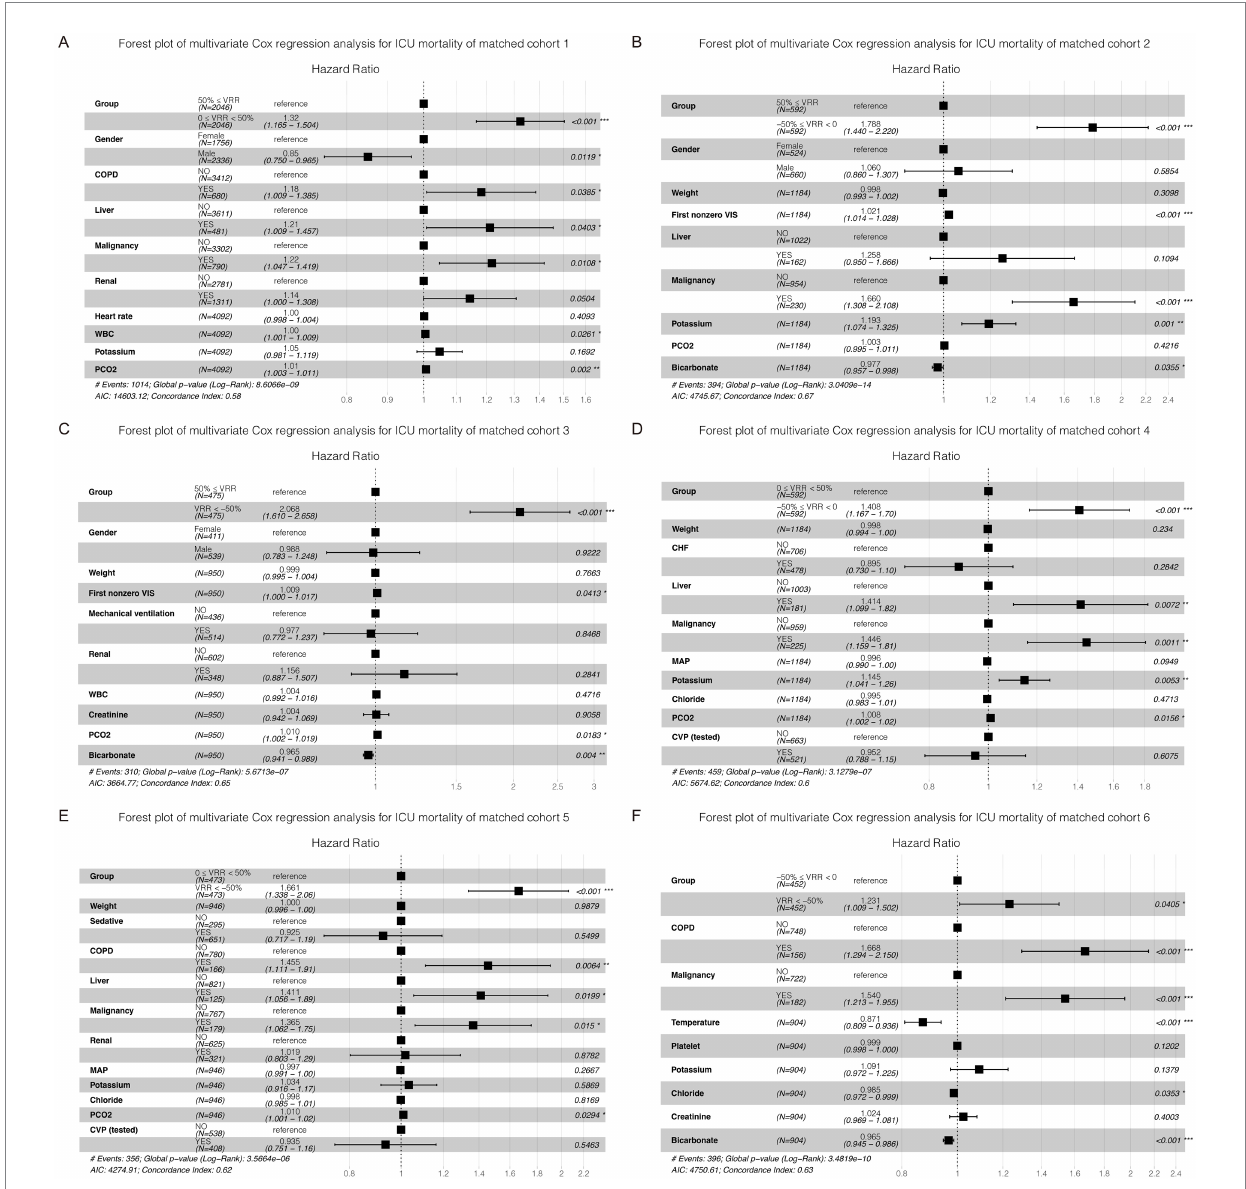
FIGURE 3 Forest plot of multivariate Cox regression analysis for ICU mortality in each cohort (A–F) after pairwise PSM. The differences for each matched cohort were